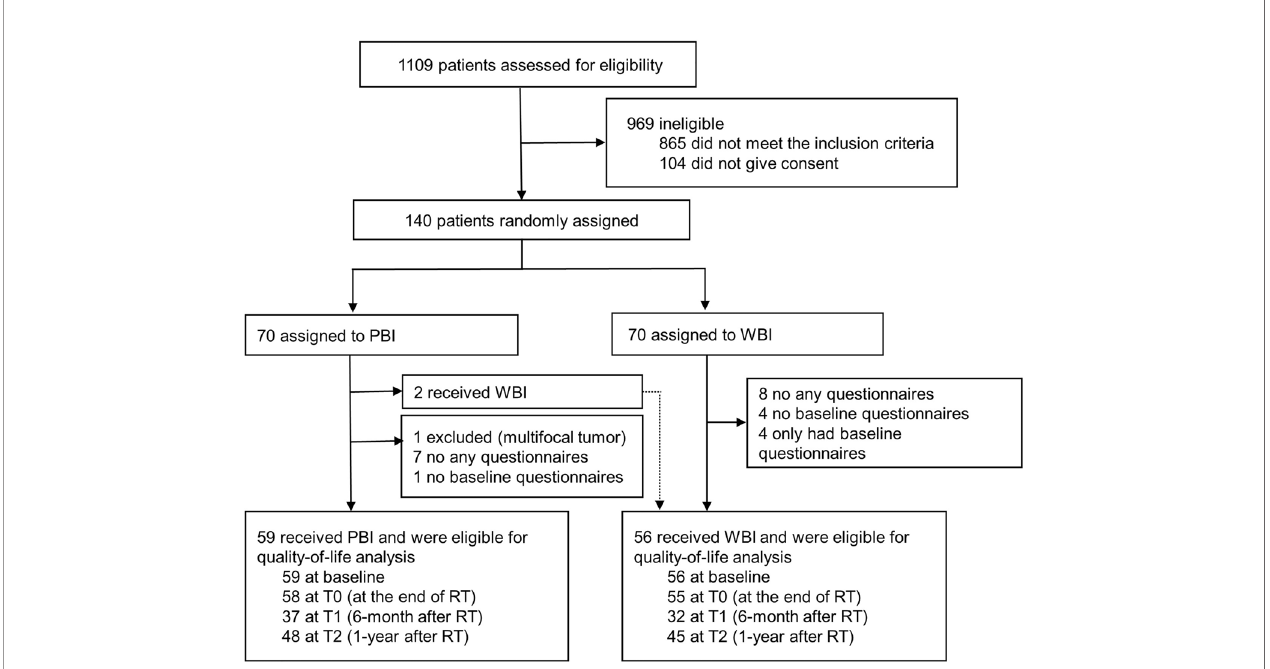
FIGURE 1 | CONSORT diagram. PBI, partial breast irradiation; WBI, whole-breast irradiation.